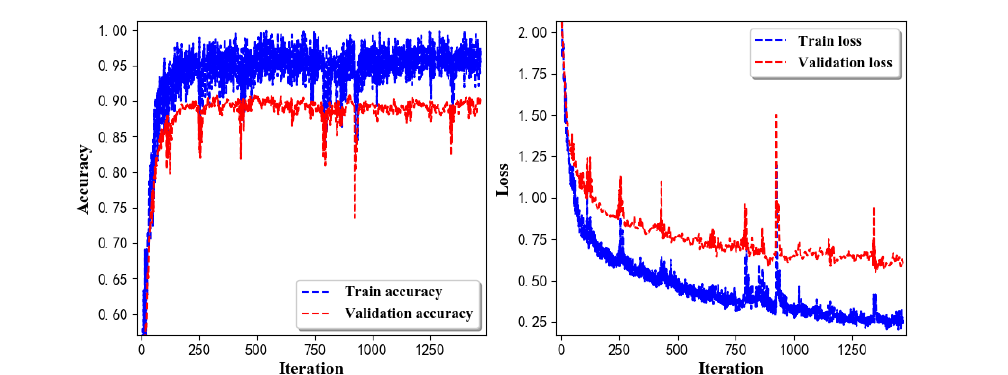
Figure 7. Accuracy ( left ) and loss ( right ) information of training and validation procedure.